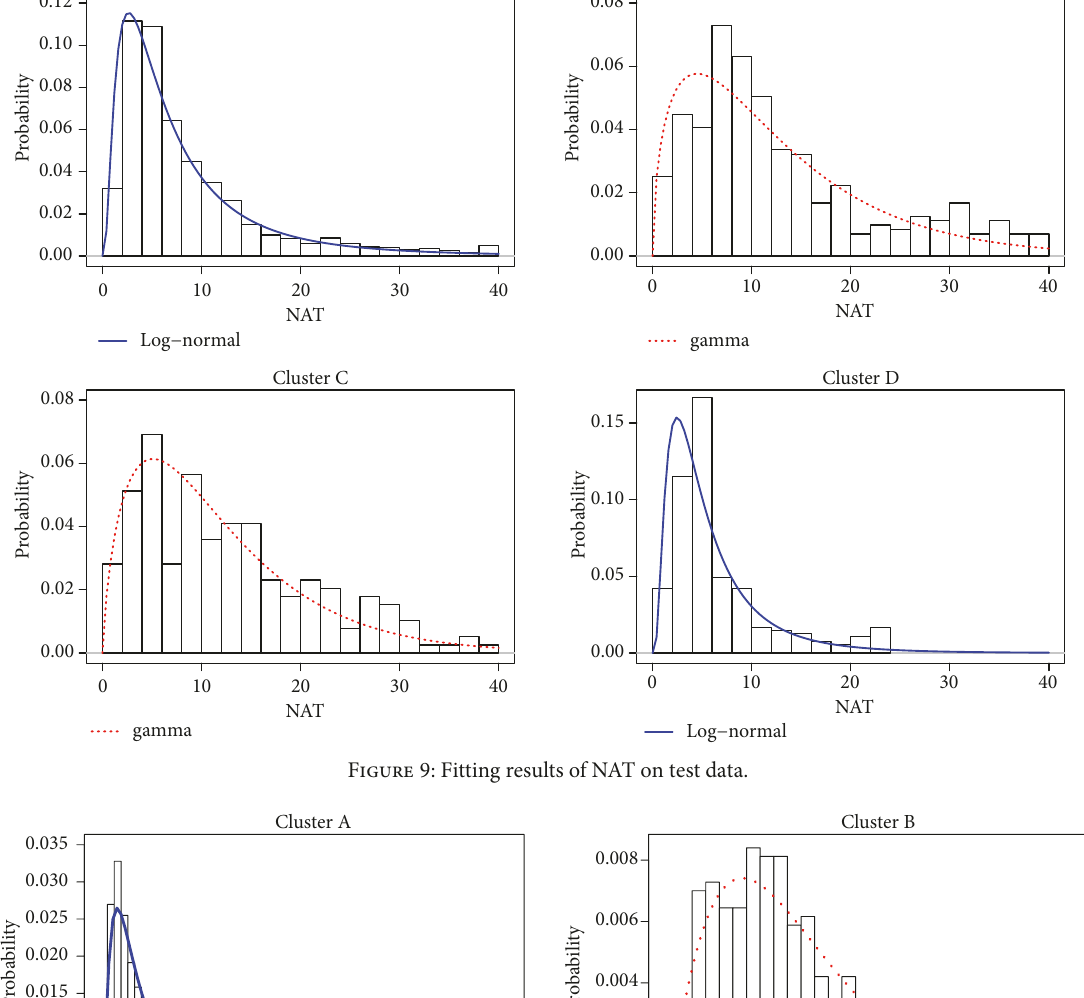
Figure 9: Fitting results of NAT on test data.